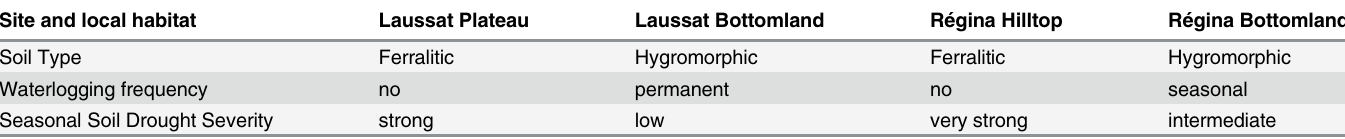
Table 1. Summary of the environmental conditions in the study sites and local habitats: soil type, waterlogging frequency and seasonal soil drought severity. Site and local habitat Régina Bottomland Soil Type Ferralitic Hygromorphic Ferralitic Hygromorphic Waterlogging frequency no permanent no seasonal Seasonal Soil Drought Severity strong low very strong intermediate Complete data are provided in S1 Table (see also Fig.